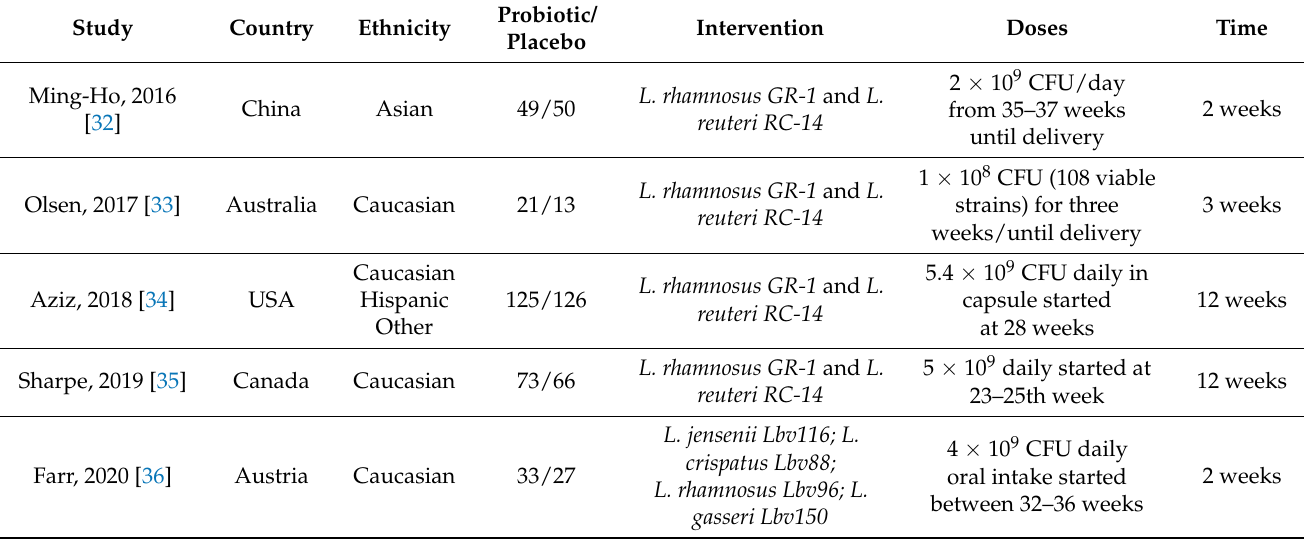
Table 1. Study and population characteristics.